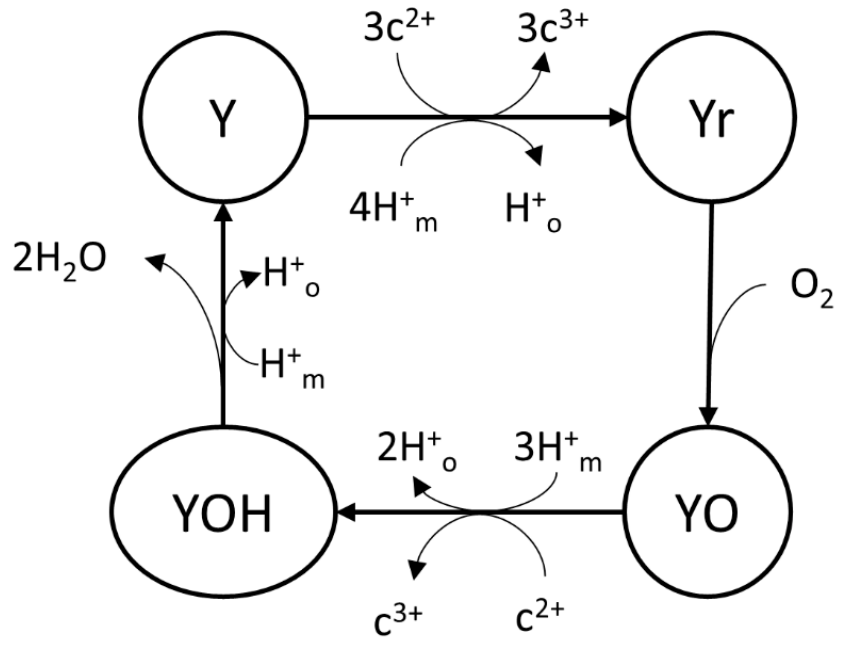
Figure 8. Schematic of the complex IV model by Demin et al. [78] with 4 stages (Y, Yr, YO, and YOH). The figure was reprinted/adapted with permission from Ref. [62].